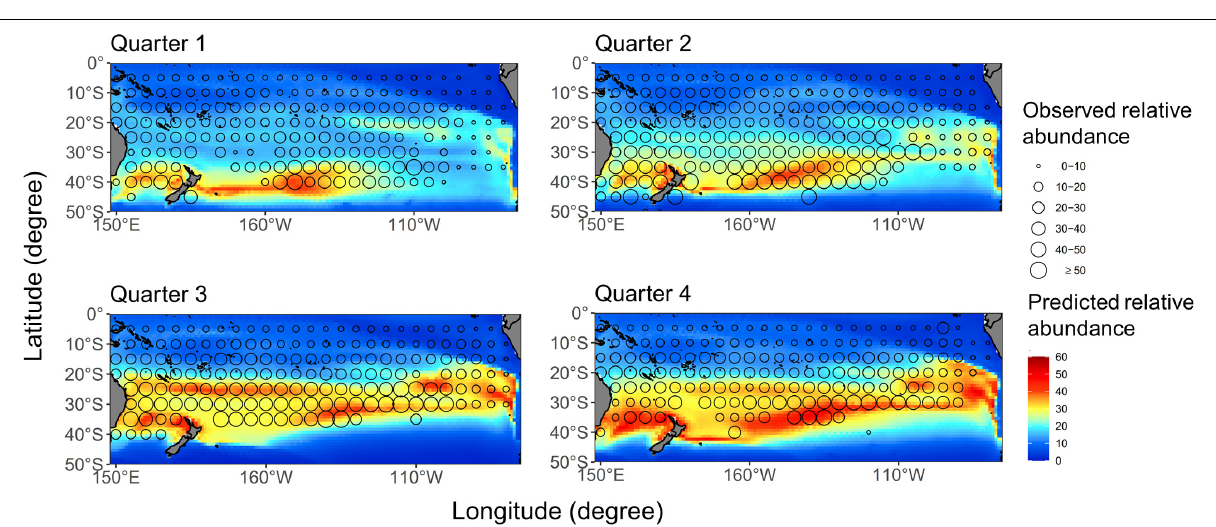
Kiribati (KI), Tuvalu (TV), and Tokelau (TK) ( Figure 6A ). The EEZ of New Caledonia (NC) has the greatest projected depletion in relative abundance by 2080 (43%). The relative abundance is projected to increase by 13 and 21% by 2080 in the EEZs of New Zealand (NZ) and Norfolk Island (NK), respectively. Similar